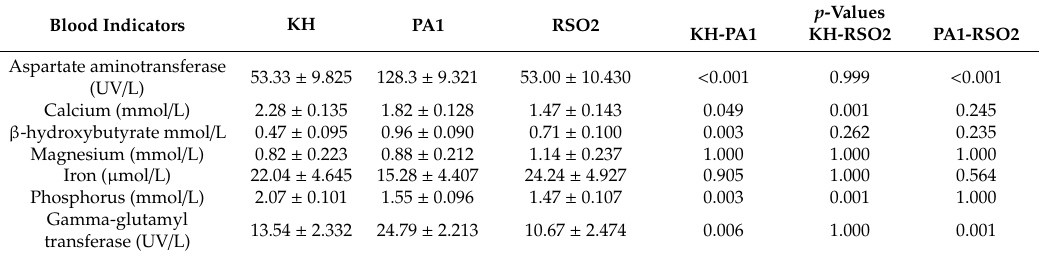
p -Values KH-PA1 KH-RSO2 PA1-RSO2